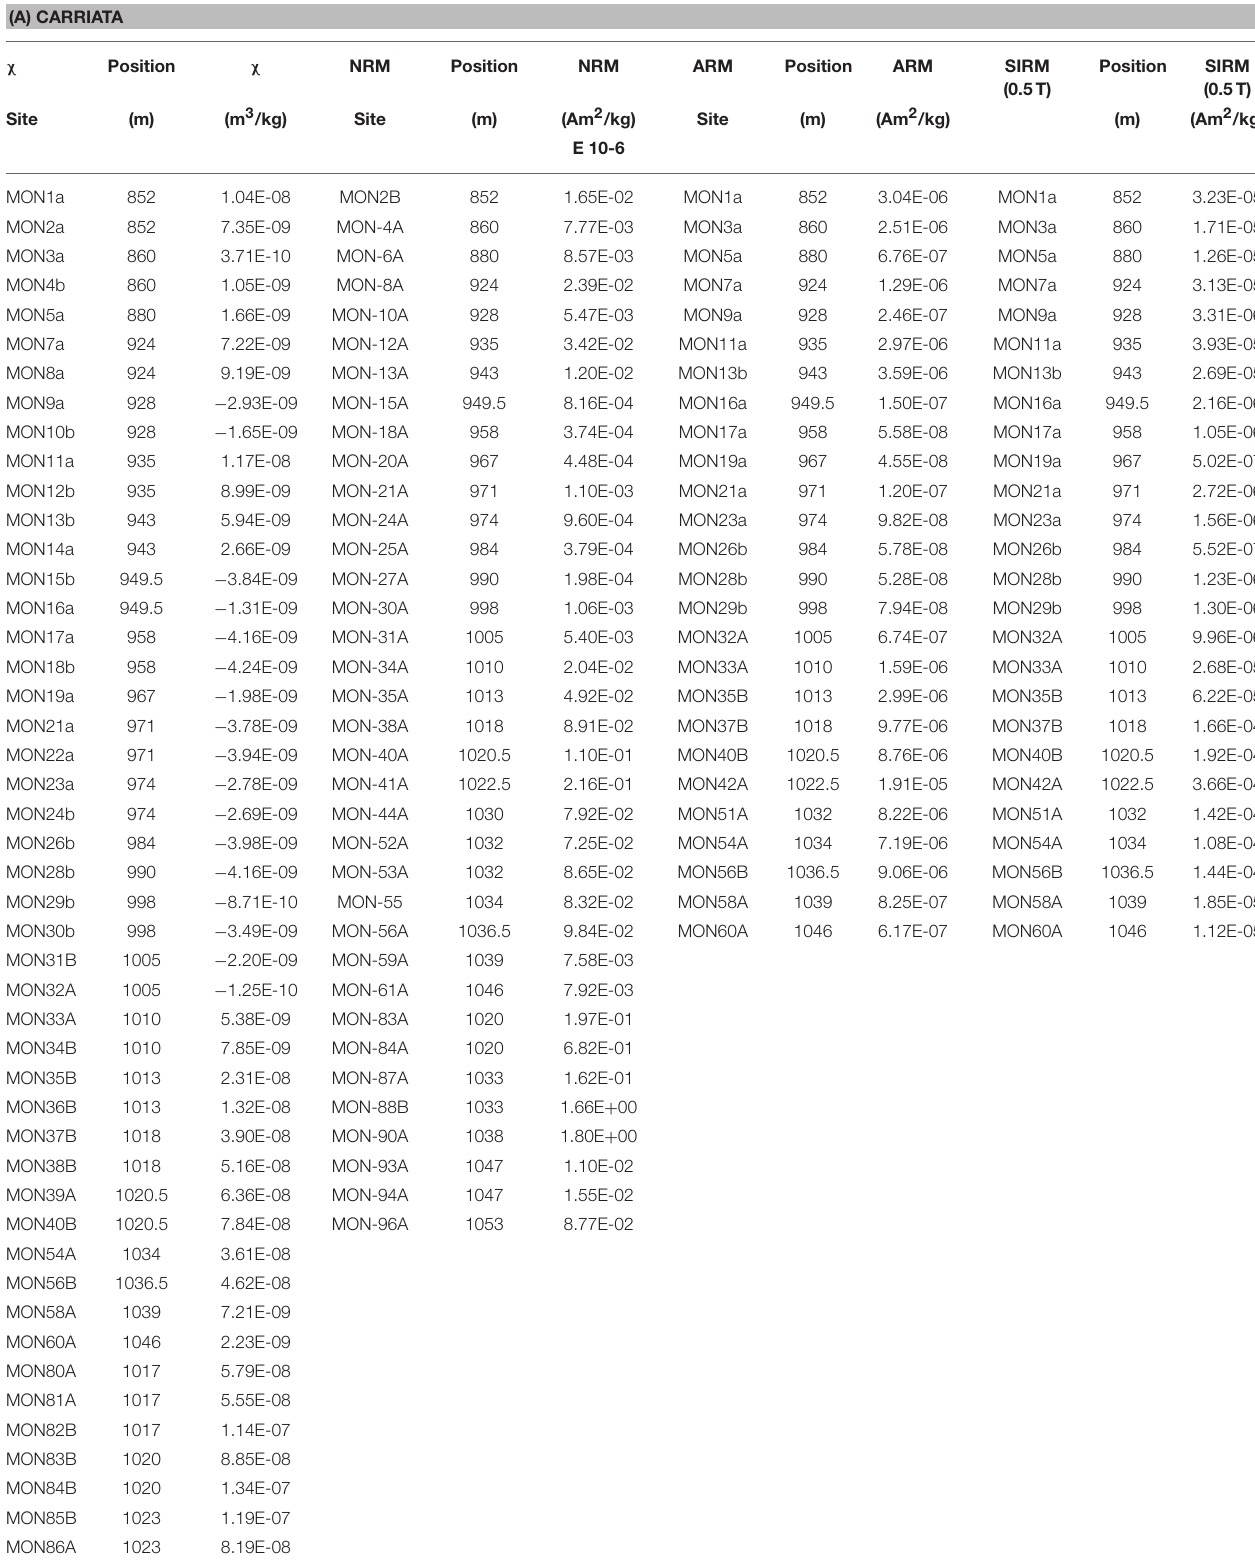
TABLE 2 | Magnetic properties normalized by mass of the samples in the four sections. (A)